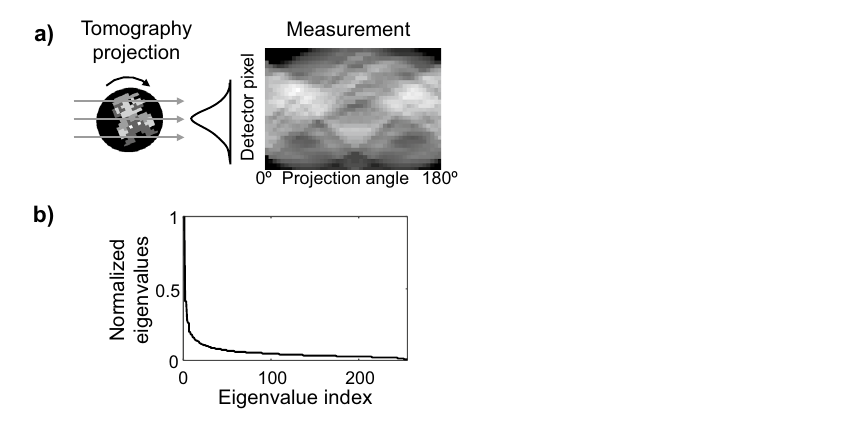
Figure 5. Fixed-point iterative solver for a tomographic reconstruction problem. ( a ) Tomographic projection and measurement of a 16 × 16 signed 3-bit “Super Mario” pixel art. ( b ) Eigenvalue spectrum of the tomographic T A projection model. The condition number κ of A is 101.80.